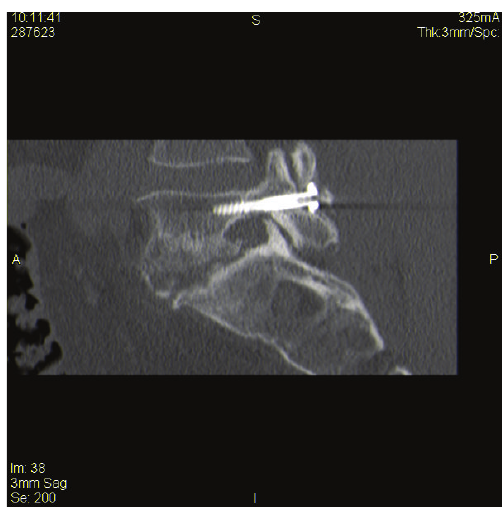
Figure 7: Sagittal view of right lumbar fixation screw in situ.